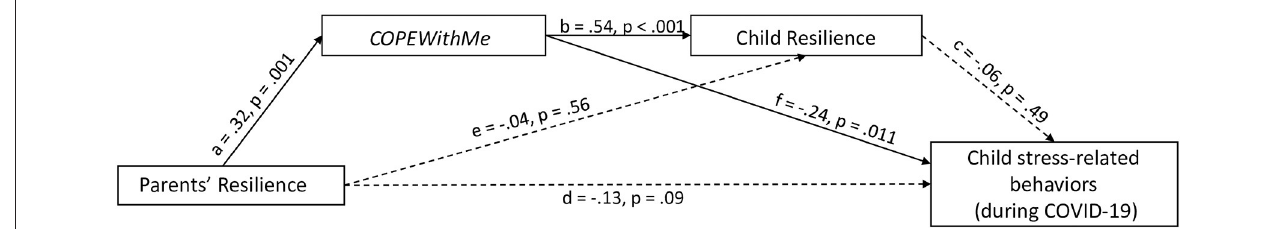
FIGURE 1 | Sequential mediation model. The figure excludes the covariate of child age; however, it is included in tests of the model. Standardized effect coefficients are